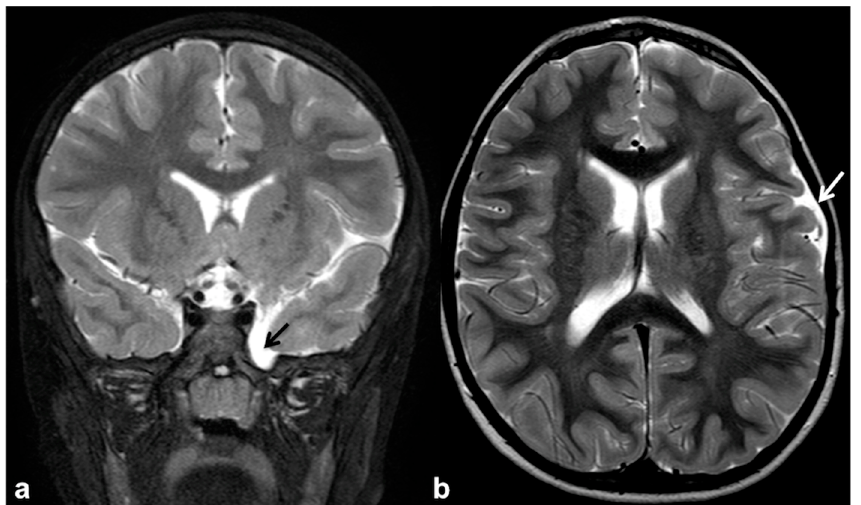
Figure 6. Coronal TSE T2w MRI ( a ) of a 14 year-old girl with NF1, showing left lateral sphenoid meningocele with no associated brain herniation (black arrow). Axial TSE T2w ( b ) of the same patient also showed a smaller dural ectasia of the cranial vault, close to the left temporo-parietal suture (white arrow).